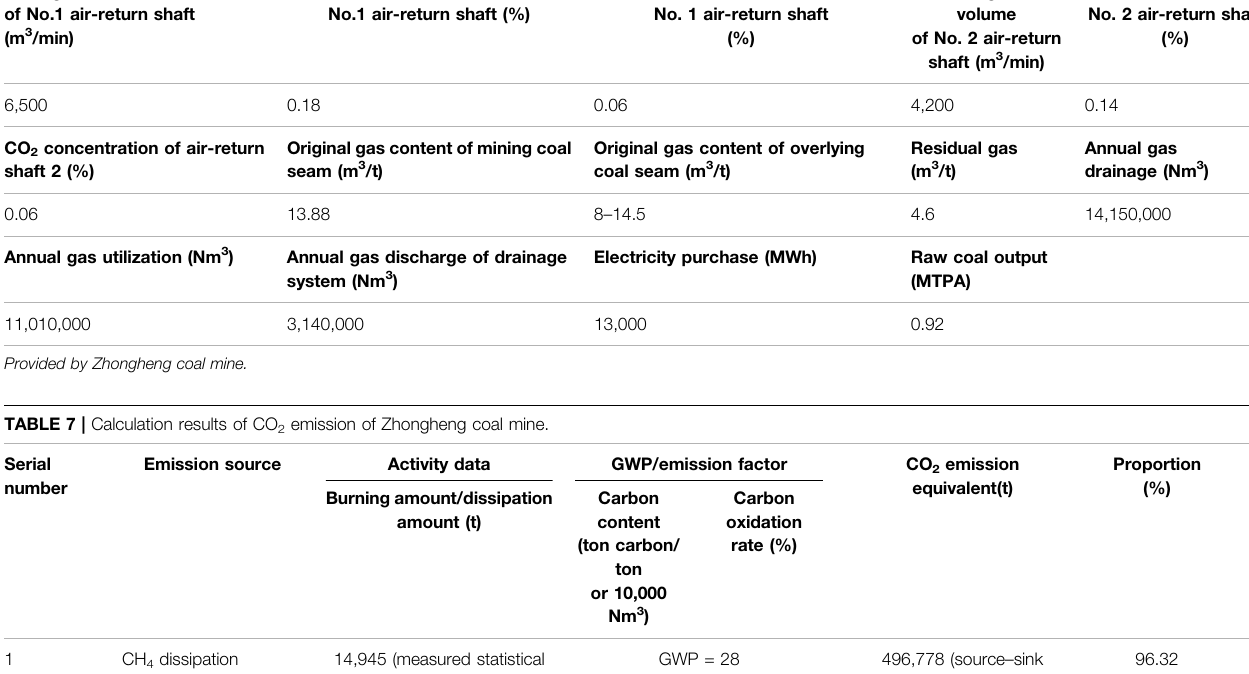
TABLE 6 | Data of carbon emission of Zhongheng coal mine in 2020. Average air volume of No.1 air-return shaft